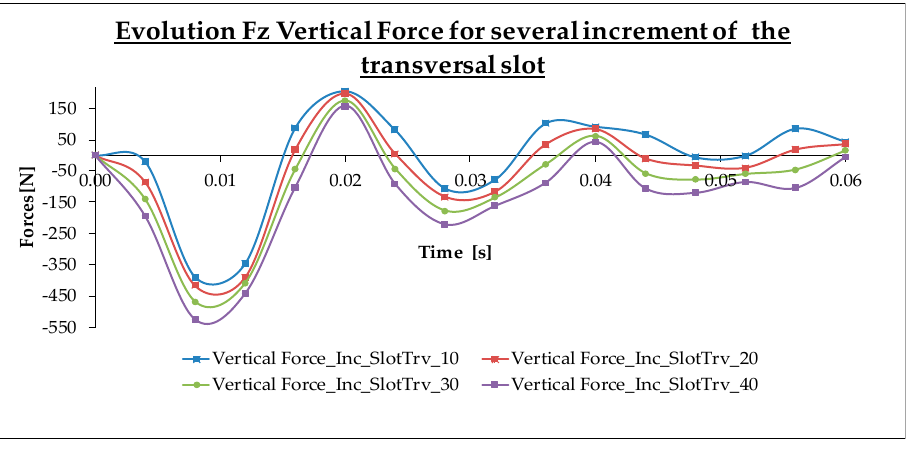
Figure 25. Levitation forces versus increment of transversal slots.